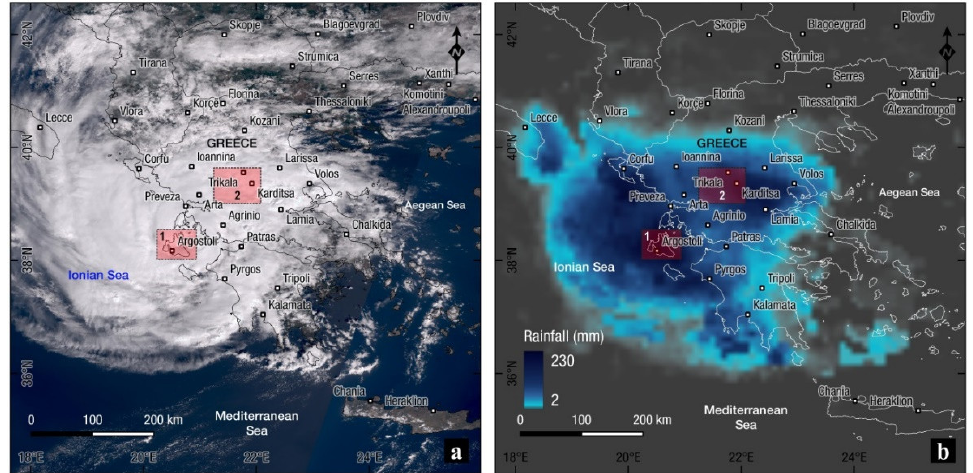
Figure 1. ( a ) Medicane Ianos over Greece, Sentinel-3 OLCI true color image acquired on 18 September 2020, one day after Medicane landing. ( b ) Satellite precipitation (NASA IMERG) of 18 September 2020. Overview boxes show the location of the two studied areas; 1—Cephalonia island, 2—western